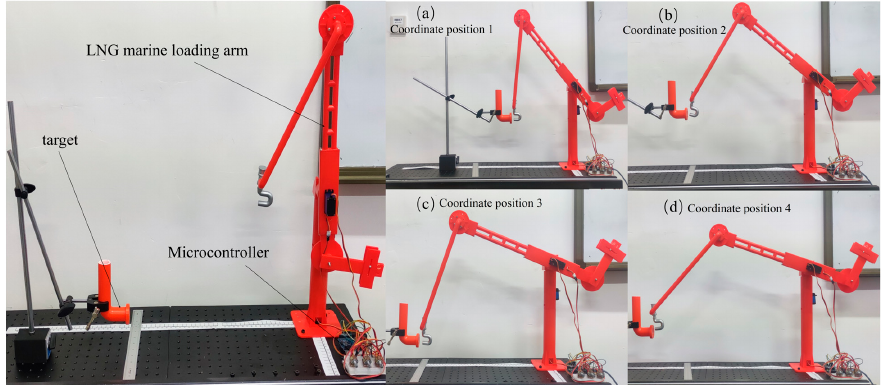
Figure 12. LNG marine loading arm model.